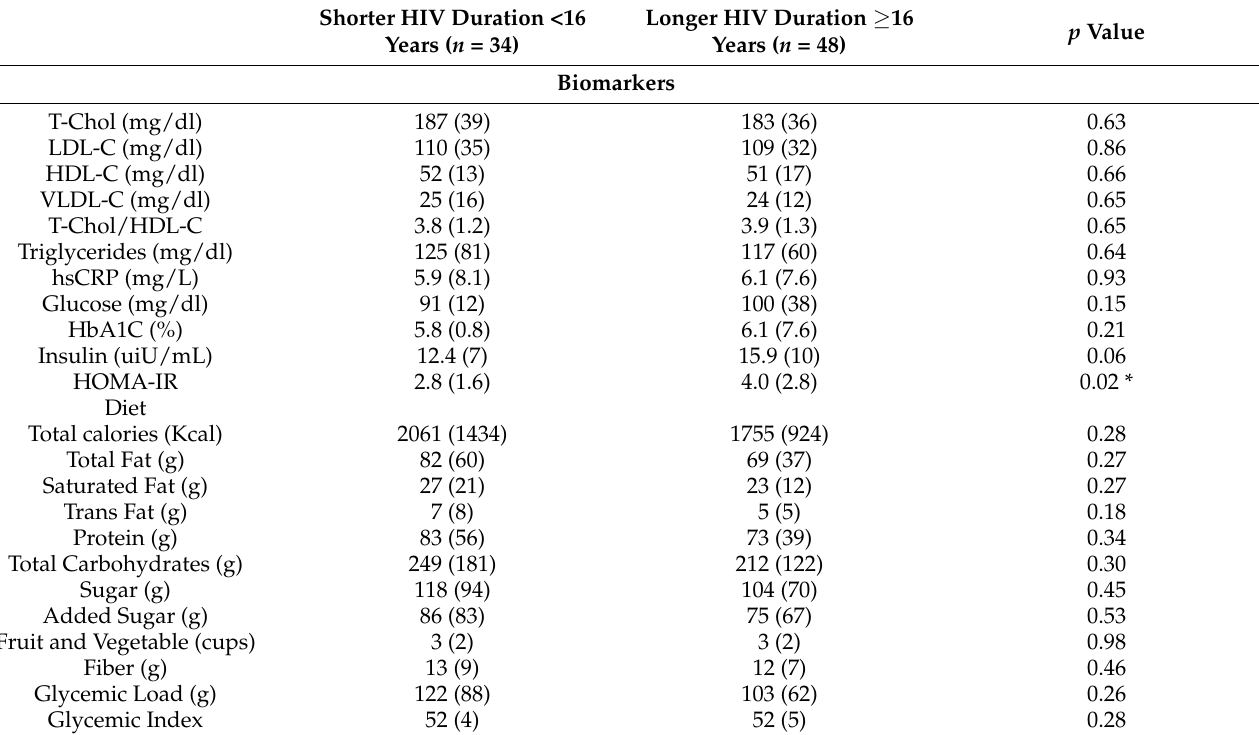
Table 2. Biomarkers and Dietary Intake of Study